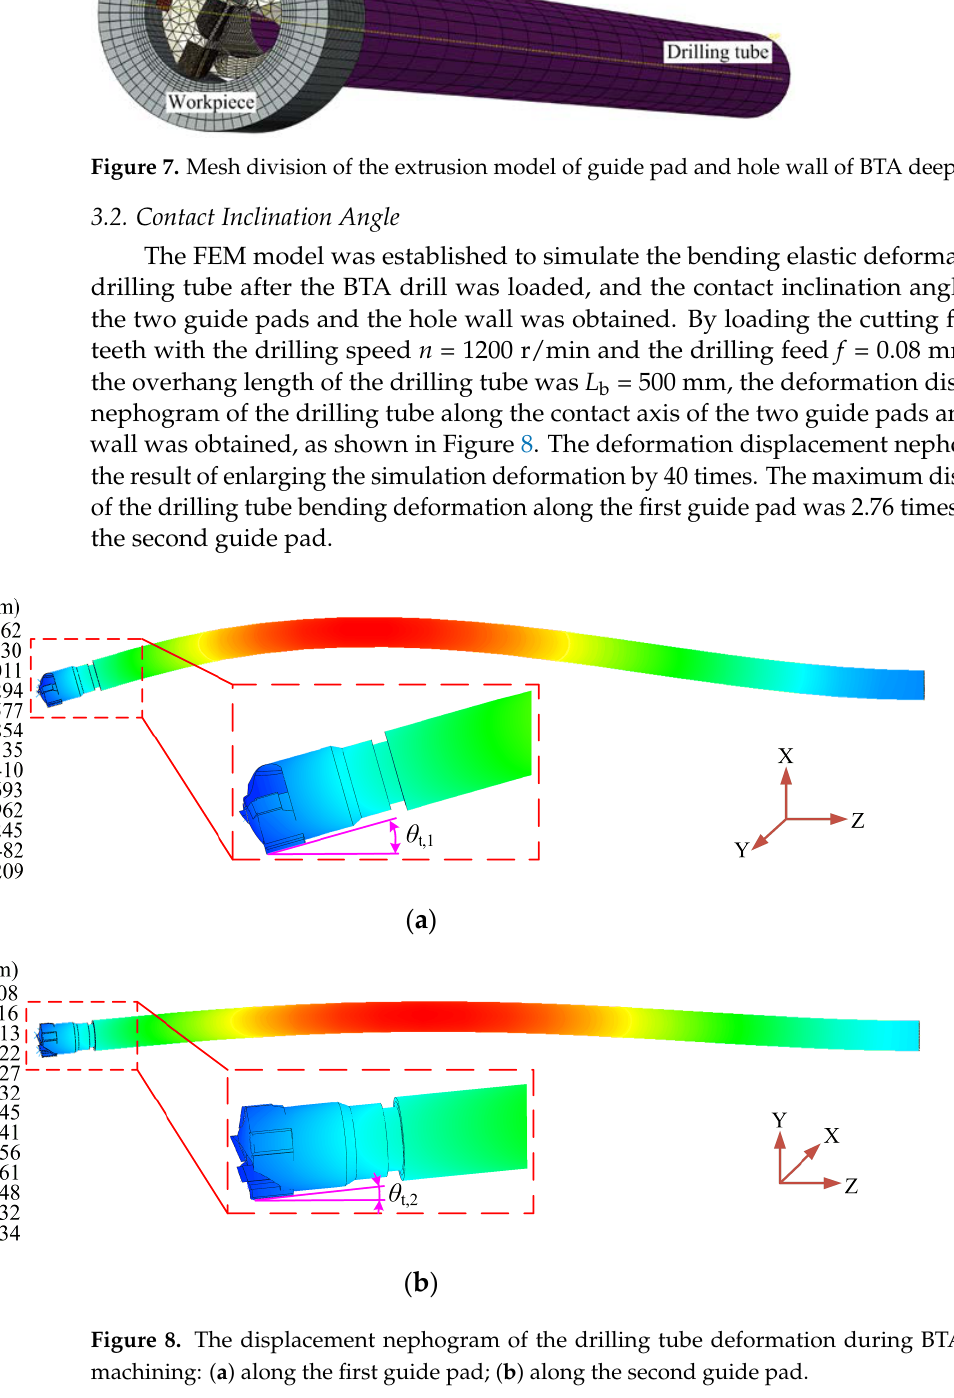
Table 2. J–C constitutive model parameters of workpiece SA-5083.